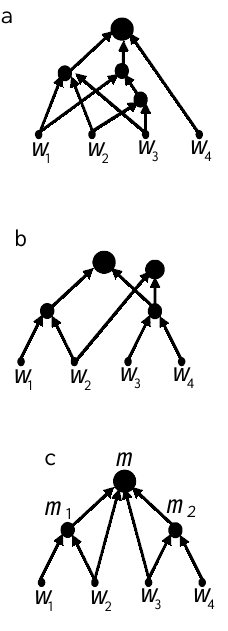
Fig 5. Hierarchies a-c violate conditions (i)-(iii)